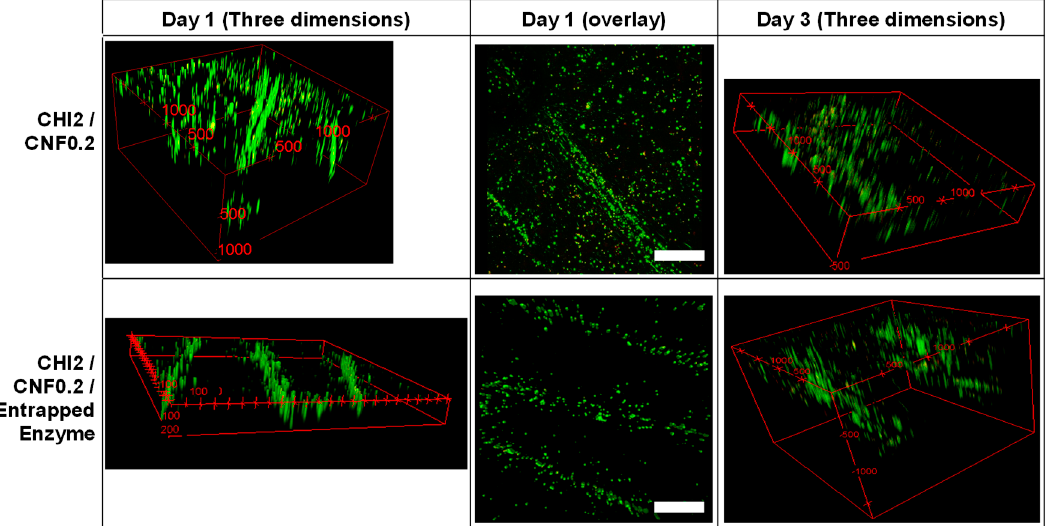
Figure 7. LIVE/DEAD assay confocal laser scanning microscopy (CLSM) images after culture of fibroblast cells in 3D printed CHI/CNF or CHI/CNF/encapsulated cellulase hydrogel scaffolds. LIVE indicator: green fluorescence; DEAD indicator: red fluorescence. Scale bars (Day 1, overlay): 500 µm. Three-dimensional frames scale: CHI2/CNF0.2, Day 1) x × y × z: 2.0 × 2.5 × 1.0 mm 3 , CHI2/CNF0.2,